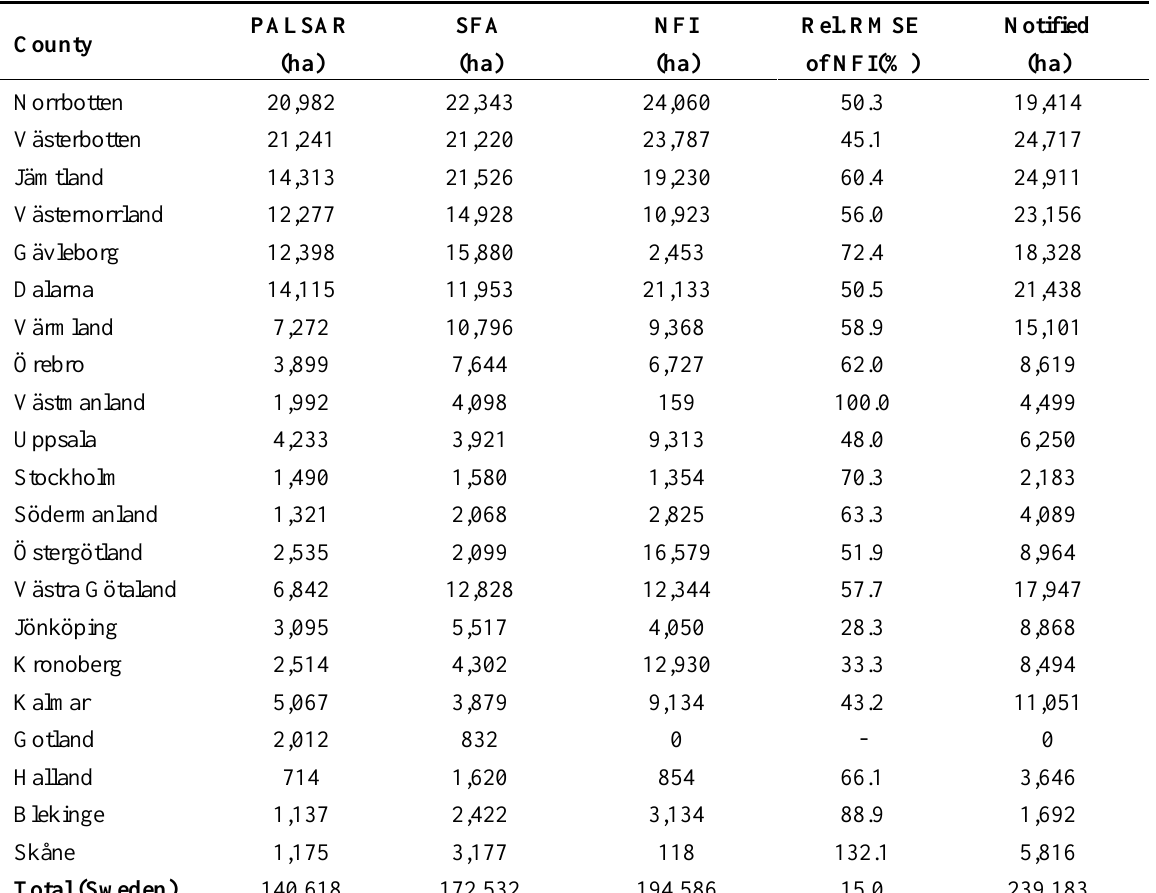
Table 5. County and national level average statistics of clear-felled areas for the time period 2008–2010 from ALOS PALSAR K&C strip data (PALSAR), the Swedish Forest Agency (SFA), the National Forest Inventory (NFI) and the notified areas of final fellings recorded by the SFA (Notified) [11,16,17]. For Västerbotten, Västra Götaland and Jönköping, a three-year average value between 2007 and 2010 is reported. For details on individual years, please refer to Table